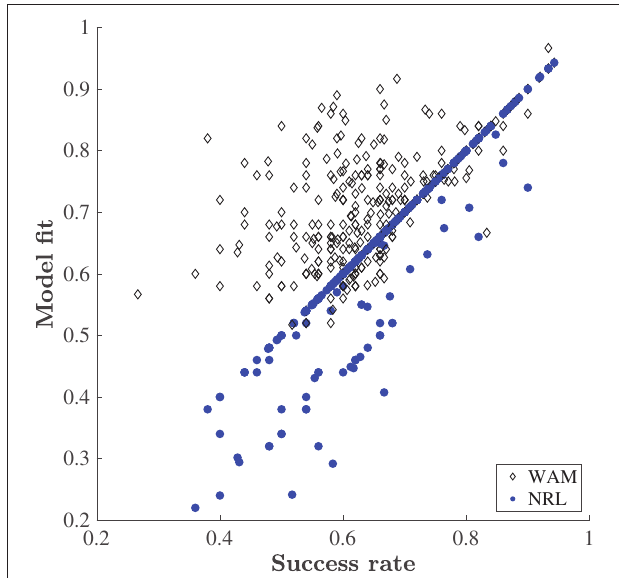
FIGURE 4 | Explanatory power of the WAM vs. the NRL. Success rate is the fraction of correct choices made by a rat in a training day. Model fit is the fraction of choices correctly predicted by the corresponding model (the WAM and the NRL) without adding exploration, i.e., based on the accumulated values